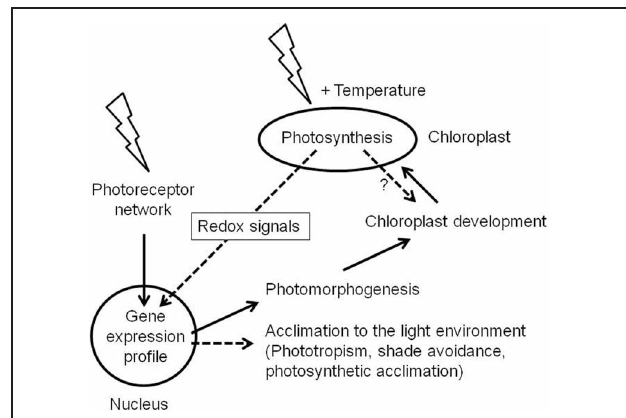
FIGURE 2 | Relation of photoreceptor- and photosynthesis-mediated light signaling. Light (indicated by flash arrows) is sensed by photoreceptors in germinating and growing seedlings. They initiate gene expression profiles in the nucleus which run the photomorphogenic programme. A central part of this programme is the build-up of chloroplasts and the photosynthetic apparatus. As soon as this is functional it serves as additional light and temperature sensing system which affects nuclear gene expression by redox signals. Potential redox signals affecting chloroplast biogenesis are indicated by a question mark. Photoreceptor - and photosynthesis-mediated signals (solid and hatched black arrows, respectively) are integrated in the nucleus and induce modifying programmes which acclimate plant growth and function to the residing environment. The interconnectivity of the respective gene expression profiles is largely unknown; however, it is assumed that photoreceptors are dominant regulators of plant development while photosynthetic redox signals preferentially control acclimation